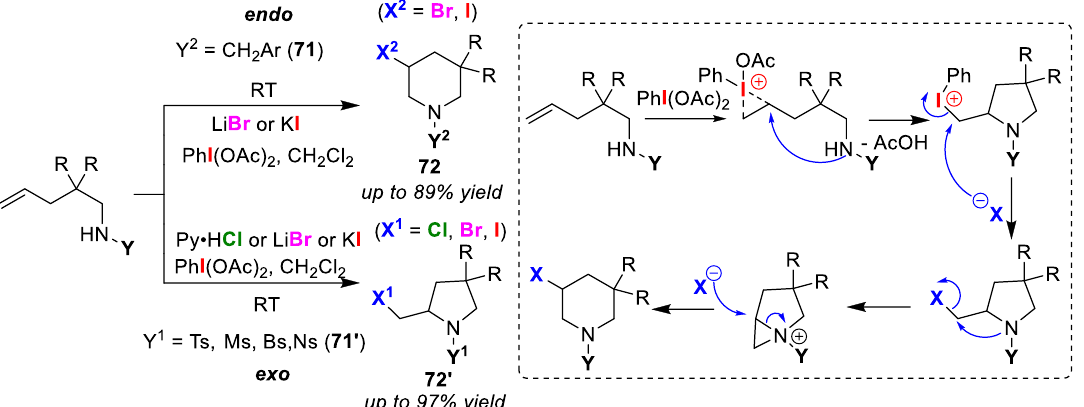
Figure 34. Endo / exo selective halo-amino-cyclization reactions of olefinic amines 71 and sulfonamides 71′ using a hypervalent iodine reagent.